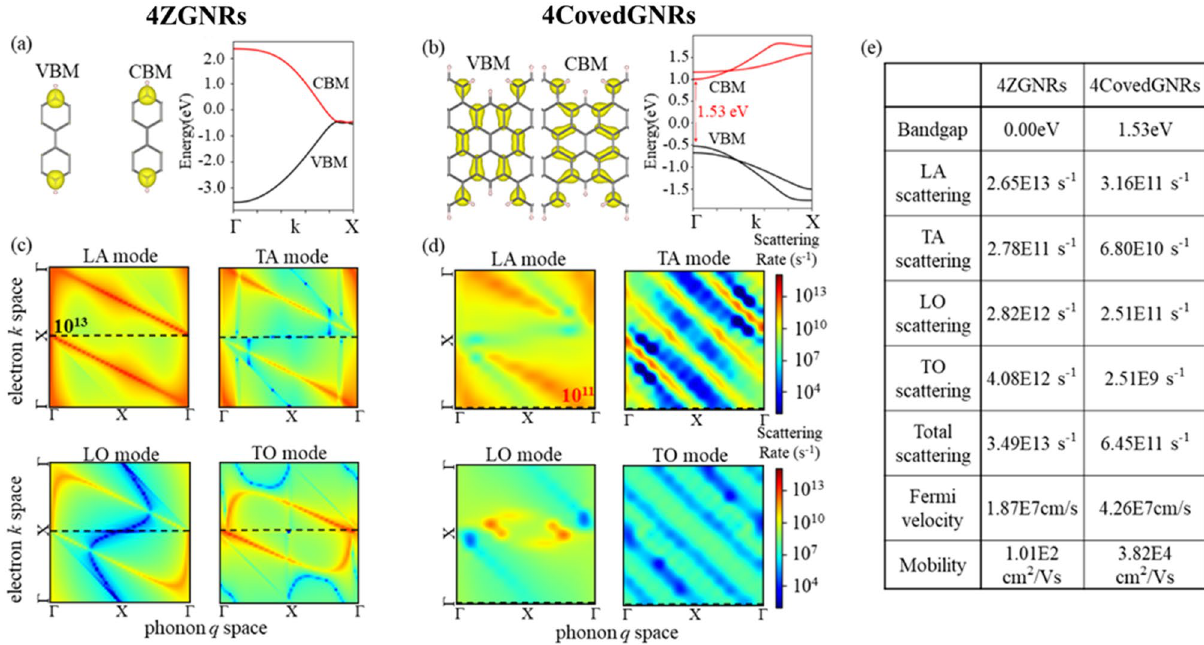
Figure 3. Electronic properties of 4ZGNRs and 4CoveGNRs, respectively. ( a , b ) The electron density distribution of CBM/VBM in unit cell and their band structure along the high symmetry lines. ( c , d ) The full band calculation of electron–phonons scattering rate at conduction band. The dash line highlights the CBM and is integrated to calculate the scattering time at CBM. ( e ) Band gap, individual scattering rate in